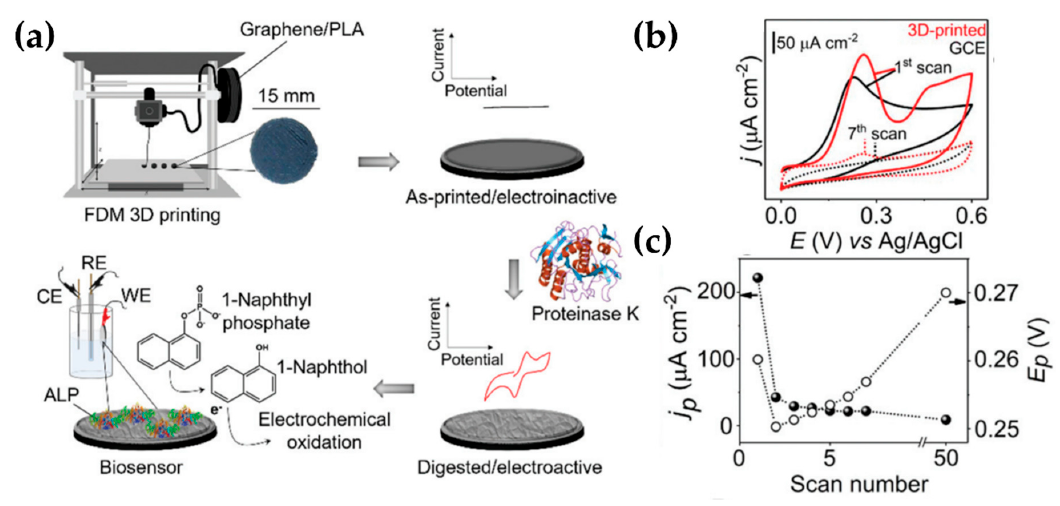
Figure 14. ( a ) Representation of the 3D-printed graphene/PLA electrodes’ fabrication, digestion/activation and application: first, coin-shaped electrodes from the graphene/PLA composite filament are 3D-printed with a fused deposition modeling printer. After proteinase K-mediated PLA digestion, the electrodes’ surface becomes eroded and electroactive. The resulting activated surface is used to immobilize alkaline phosphatase (ALP) enzyme via adsorption. ALP catalyzes the conversion of 1-naphthyl phosphate into 1-naphthol, which is electrochemically oxidized at the surface of 3D-printed electrodes. Electrooxidation of 1-naphthol at the digested 3D-printed sur- faces; ( b ) CVs performed on the activated 3D-printed electrodes and glassy carbon electrode (GCE) in the presence of 1-naphthol (60 μ M); ( c ) progression of maximum current density ( jp ) and peak potential ( Ep ) with the number of scans, on activated 3D-printed surfaces. Reprinted with permission from reference [46]. Copyright © The Royal Society of Chemistry 2019.